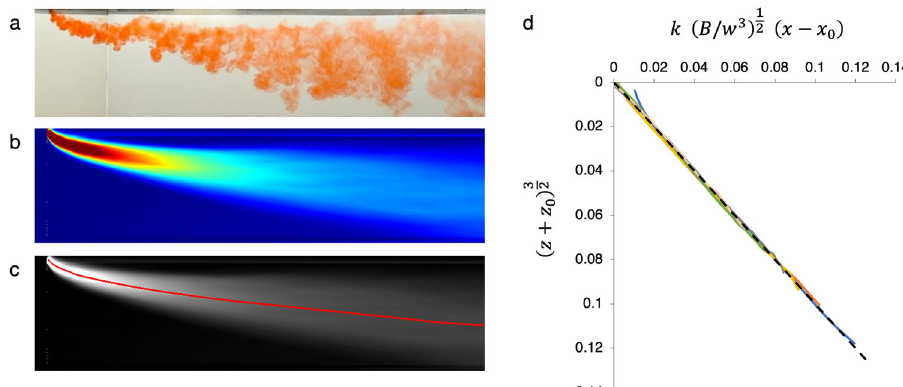
Fig. 6 Laboratory-scale wind-blown plumes. a Experimental picture of a wind-blown plume illustrating the highly turbulent nature of the fl ow. b Time average of the images of the plume, in false colour, showing the evolution of the ensemble average of the dye concentration in the plume. c Image showing the centre of mass of the plume at each point downwind (red curve), based on the vertical distribution of the mass of dyed fl uid at that point. d Comparison (cid:1) (cid:3) (cid:1) (cid:3) (cid:1) (cid:3) 3 = 2 as a function of k B = w 3 1 = 2 x (cid:3) x of the scaling law for the shape of the plume, plotted as z þ z 0 . The results of four experiments (coloured lines) 0 are compared to the prediction of the model (black line).